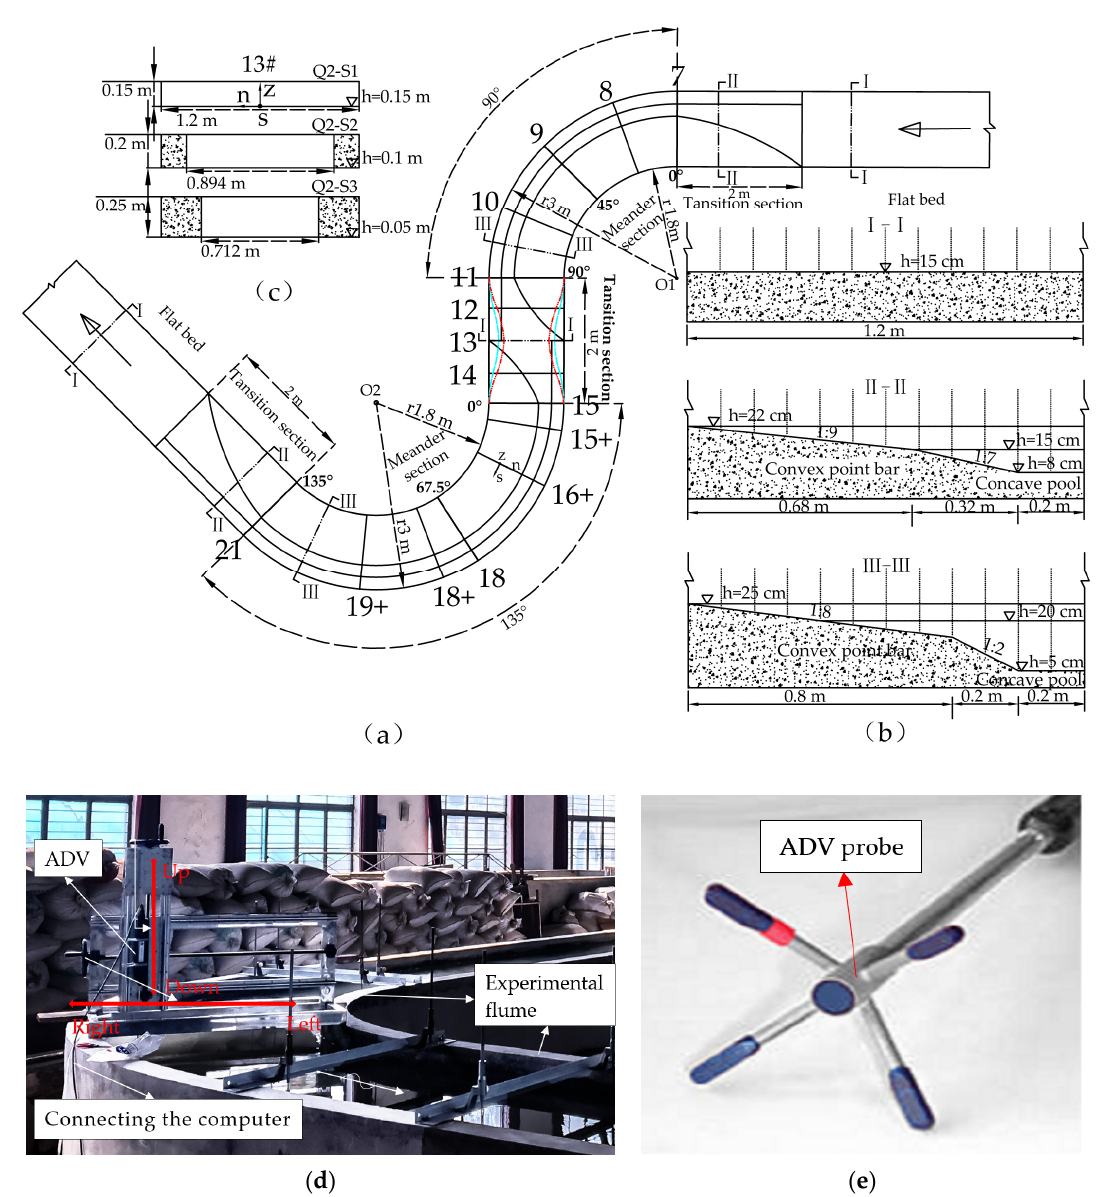
Figure 2. Design of the experimental flume. ( a ) Planform of the continuous bend. ( b ) Typical cross-section geometry. ( c ) Configuration of the section 13# at different scenarios. ( d ) Experimental setup on the model. ( e ) Acoustic Doppler Velocimeter (ADV) probe on the experimental